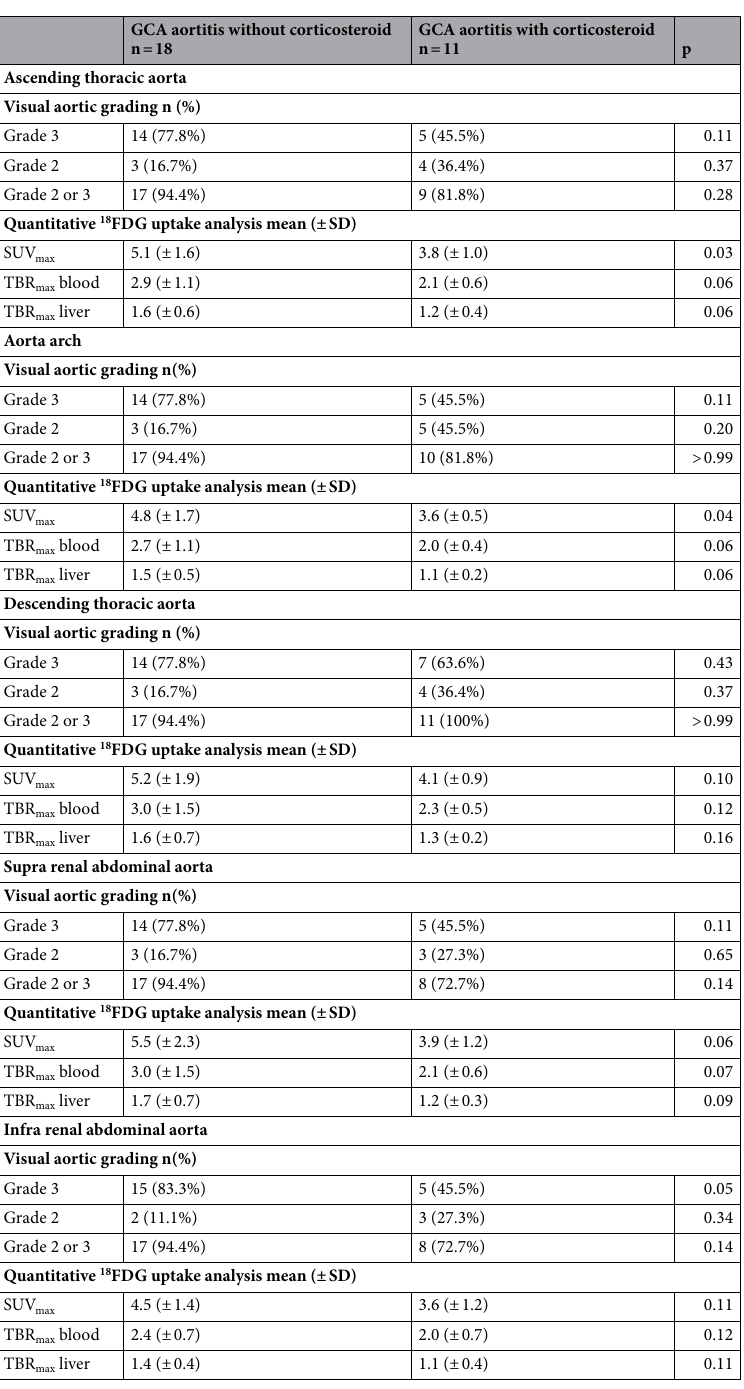
Table 3. FDG-PET/CT uptake patterns comparison between aortitis cases with or without corticosteroid therapy before